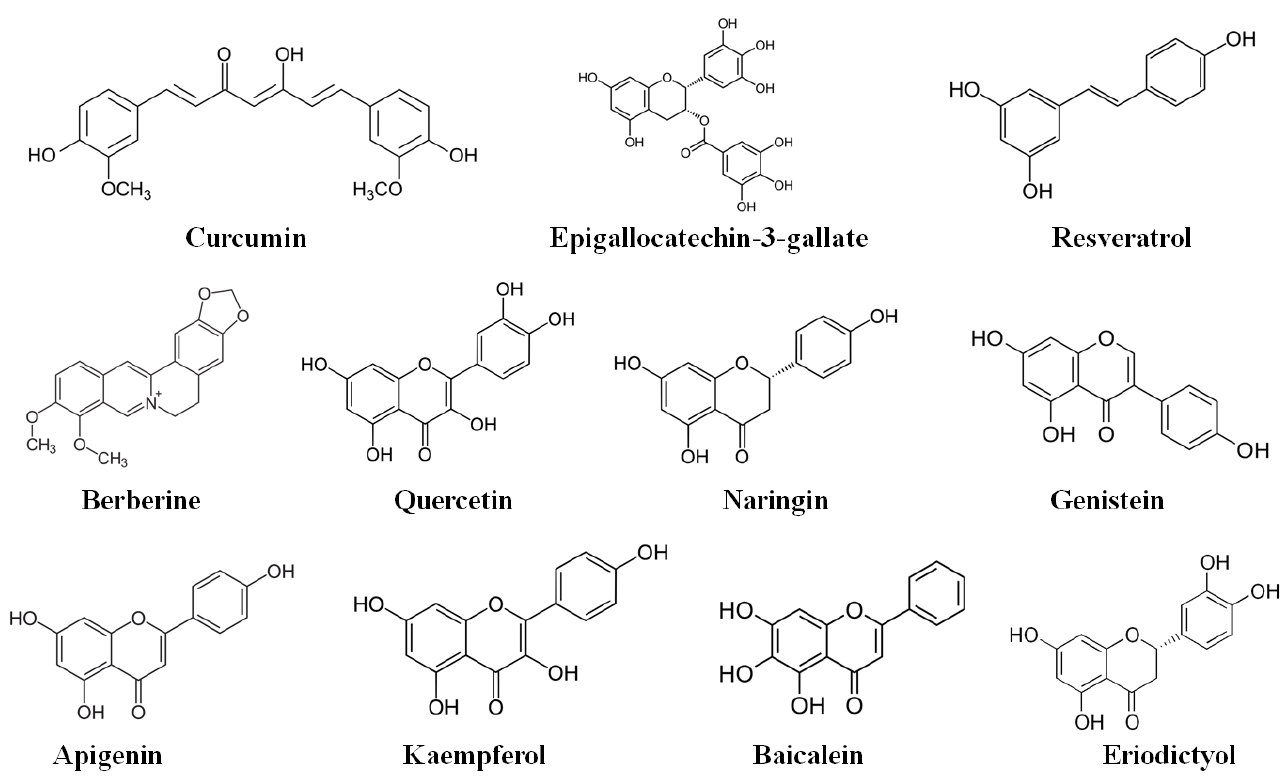
Figure 3. Chemical structures of bioactive compounds that have the potential to treat inflammation in microvascular complications of diabetes. Table 1. Classification and major dietary sources of anti-inflammatory bioactive compounds that have the potential to treat microvascular complications of diabetes.